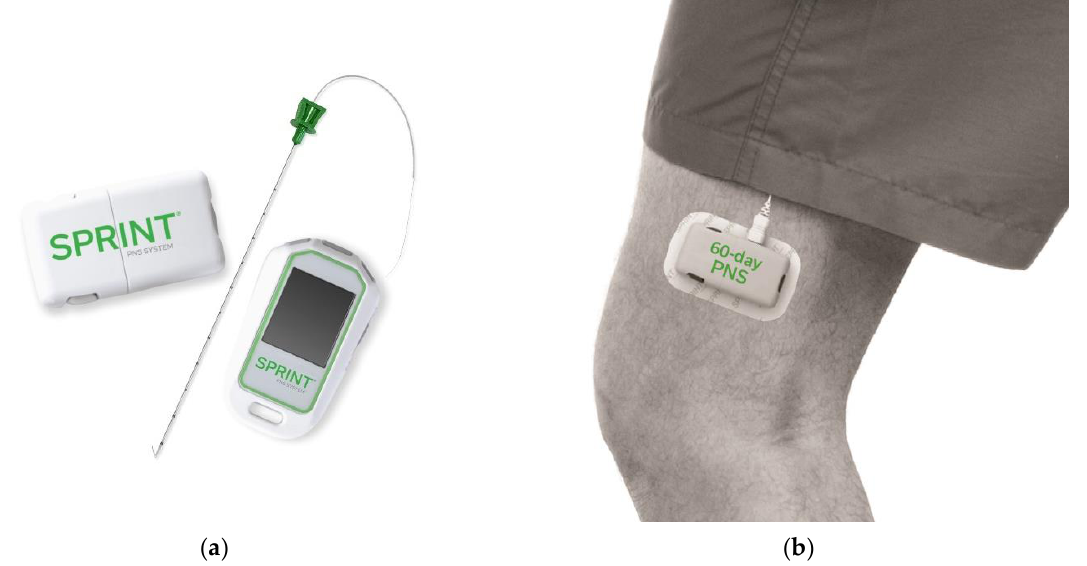
Figure 2. The SPRINT PNS System utilized by Langford and Mauck to treat meralgia paresthetica pain is pictured on the left ( a ). A second picture ( b ) depicts the external implantable pulse generator as it would be worn by a patient (images courtesy of SPR Therapeutics).